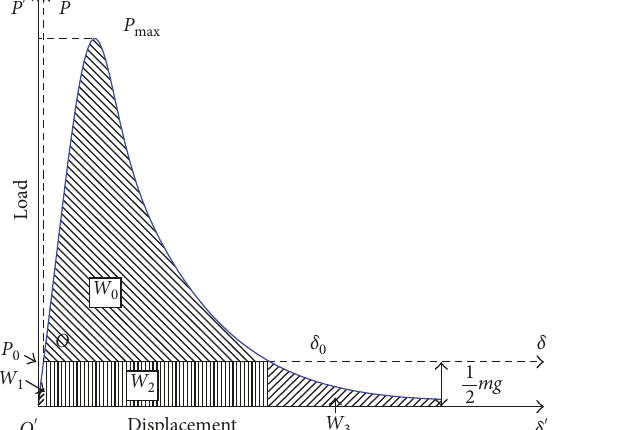
Figure 4: A load-displacement curve for a stable three-point bend test on a single-edge notched beam. W displacement curve if there is no compensation for the energy supplied by the weight of the beam, m is the weight of the beam (between the supports), and g 9.81m/s 2 (cid:30)